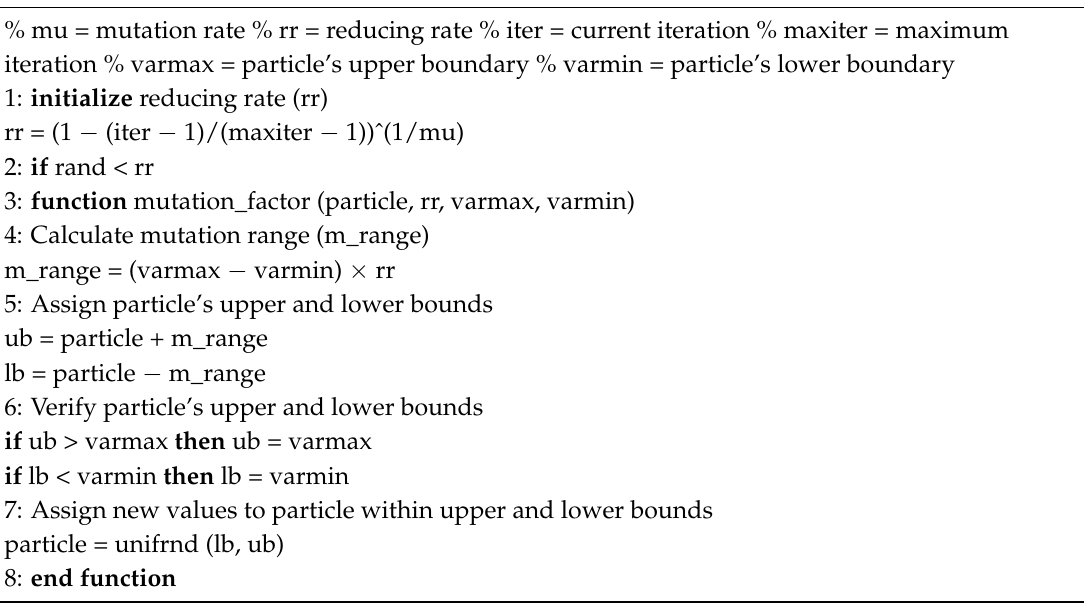
Algorithm 1. Pseudocode for mutation